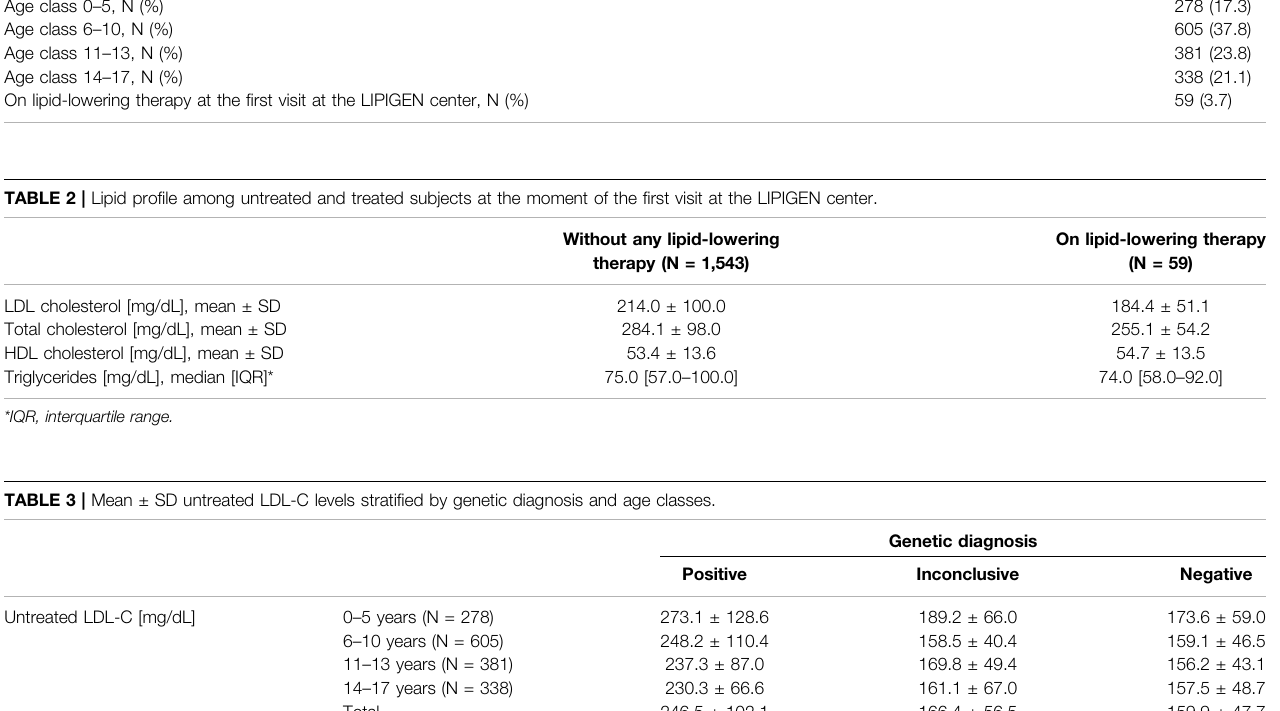
TABLE 1 | Characteristics of the LIPIGEN pediatric cohort. Male, N (%)